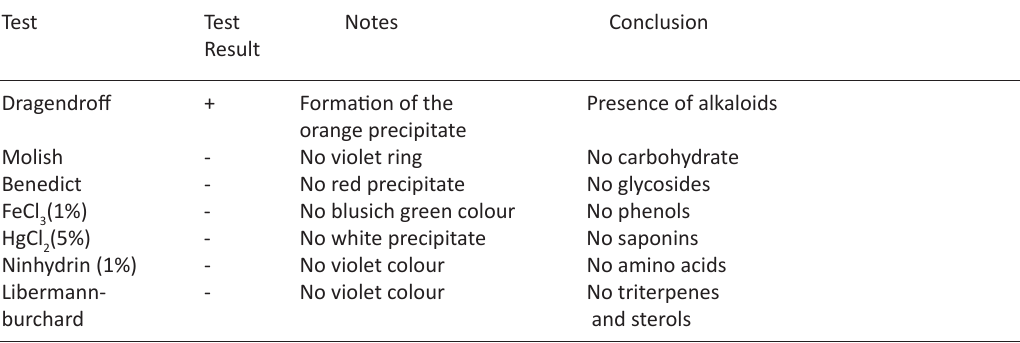
Table 2. TLC of alkaloid extracted from myristica fragrans Eluent system